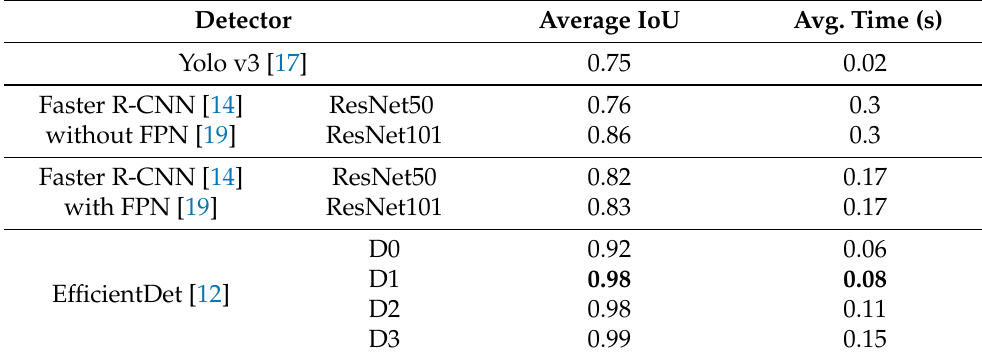
Table 1. Image detection performance with image collage inputs applied to object